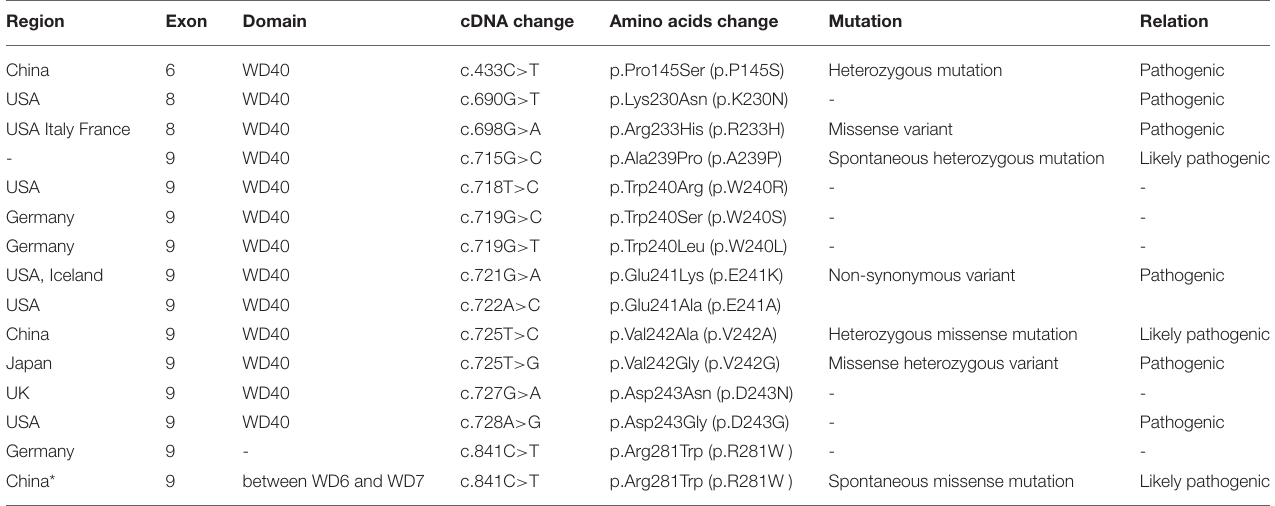
TABLE 1 | The mutated genes found in COPA